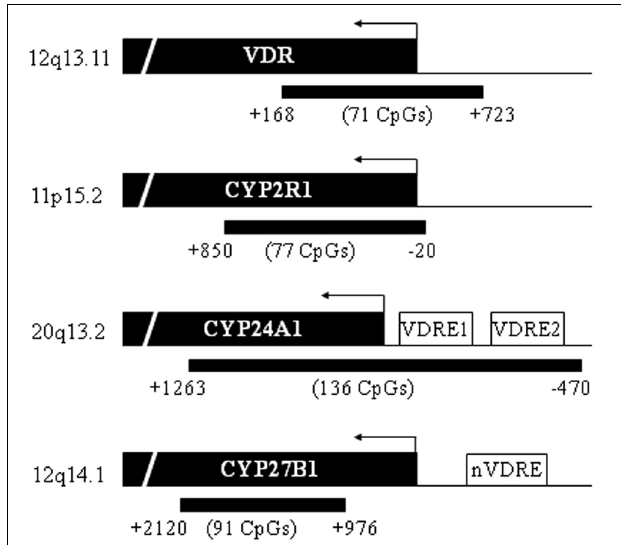
FIGURE 2 | Location of CpG islands in the promoter region of vitamin D tools genes. VDR is located on 12q13.11 (chr12:48235320-48298814), CYP2R1 on chromosome 11p15.2 (chr11:14899556-14913751), CYP24A1 on chromosome 20q13.2 (chr20:52769988-52790516), and CYP27B1 on 12q14.1 (chr12:58156117-58160976). The locations of the CpG islands are indicated (black bars) relative to start of the gene locus (not to TSS) according to UCSC Genome Browser Homepage (GRCh37/hg19) (Karolchik et al., 2014). Number of CpGs located within each island is stated. Two vitamin D responsive elements (VDRE) are located in the proximal CYP24A1 promoter region and one nVDRE is located in the CYP27B1 promoter